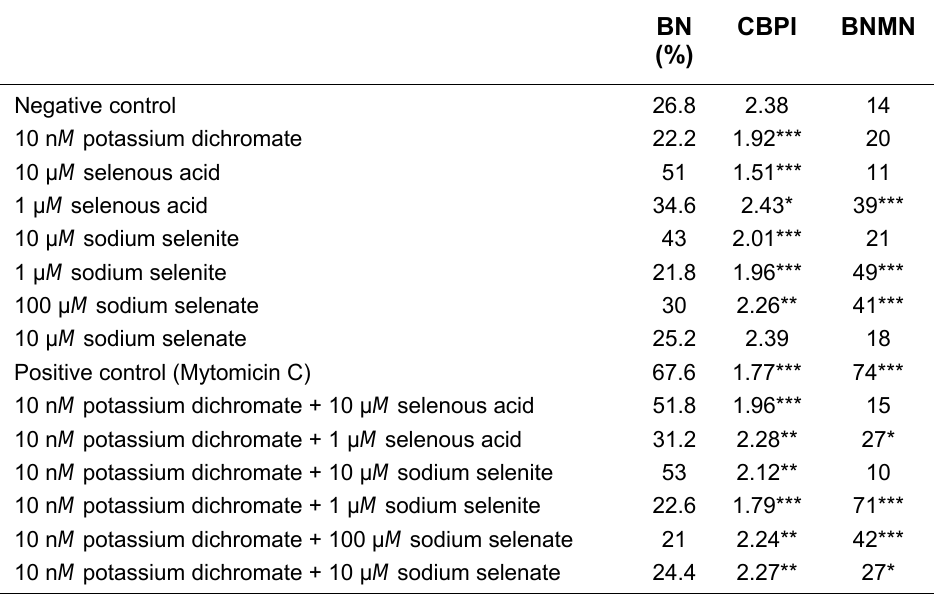
Assays Conducted with 10 n M Potassium Dichromate and Selenium Compounds in TK6 Lymphoblastoid